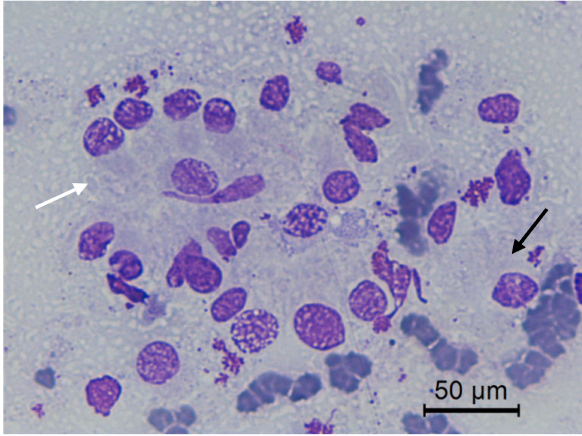
Figure 7. Jenny’s endometrial cytology collected by CB in early diestrus. Cluster (white arrow) and individual (black arrow) endometrial epithelial cells. Granular background present. Modified Wright’s stain 400×.